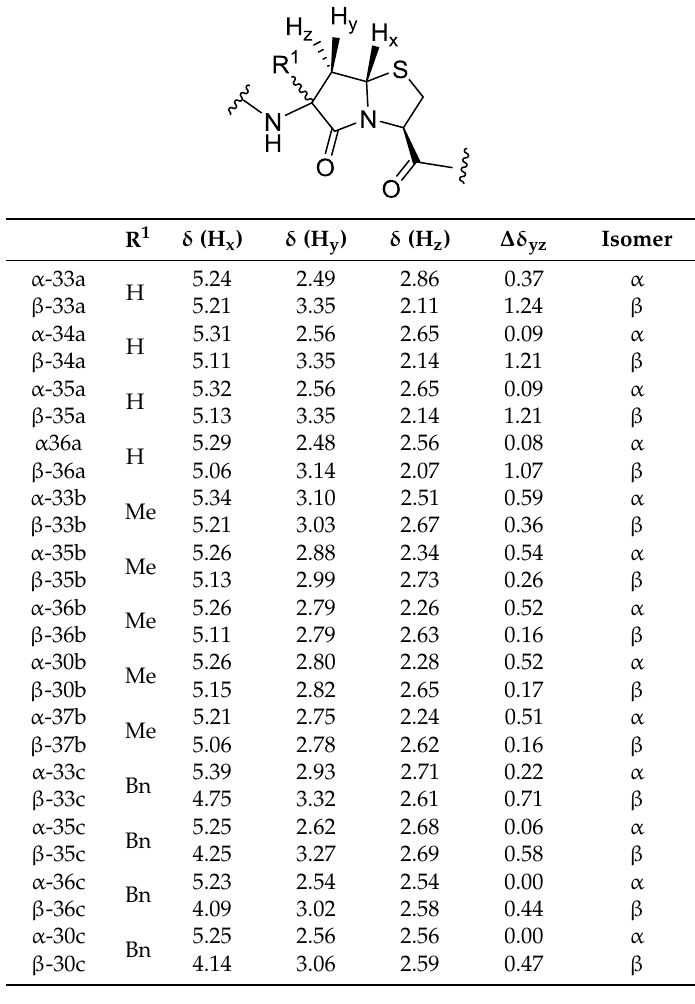
Figure 4. Remote nOe at H-8 and H-9 from irradiation at H-13 of α-30b